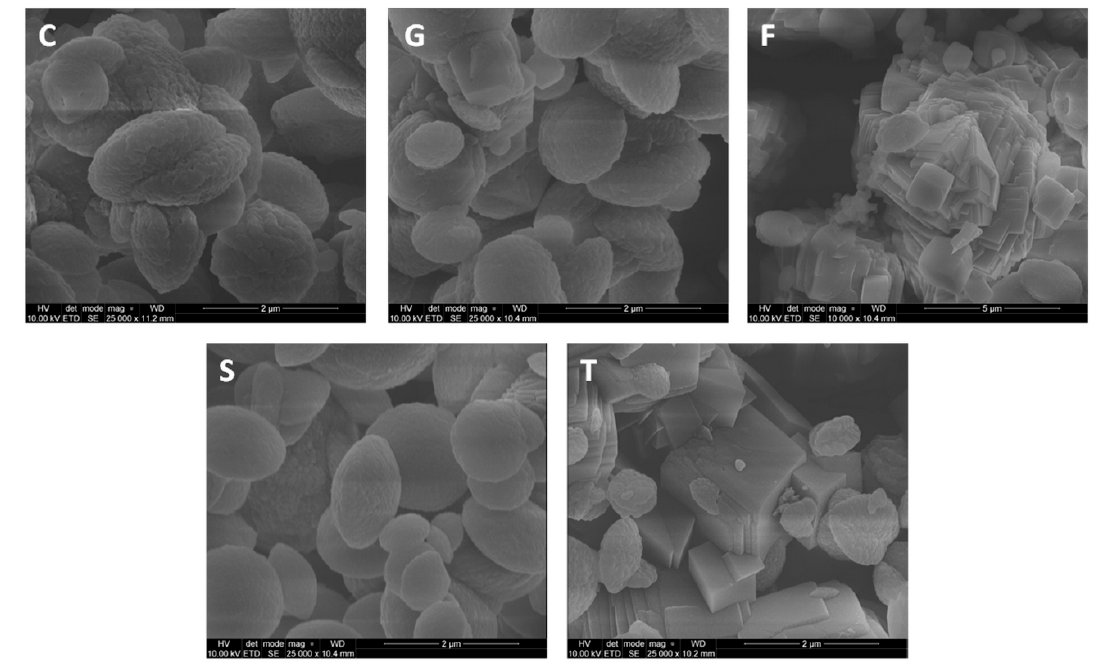
Figure 5. SEM images of calcium carbonate particles precipitated without additives C and with saccharides: G —glucose, F —fructose, S —sucrose, T —trehalose.